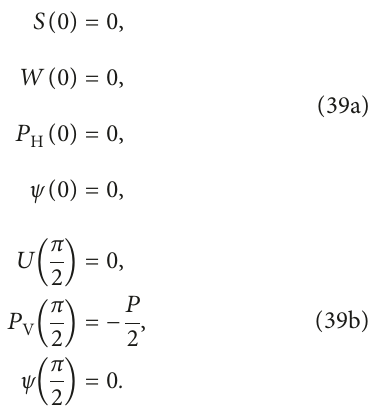
Figure 8: Variations of U versus P with different values of n . Δ